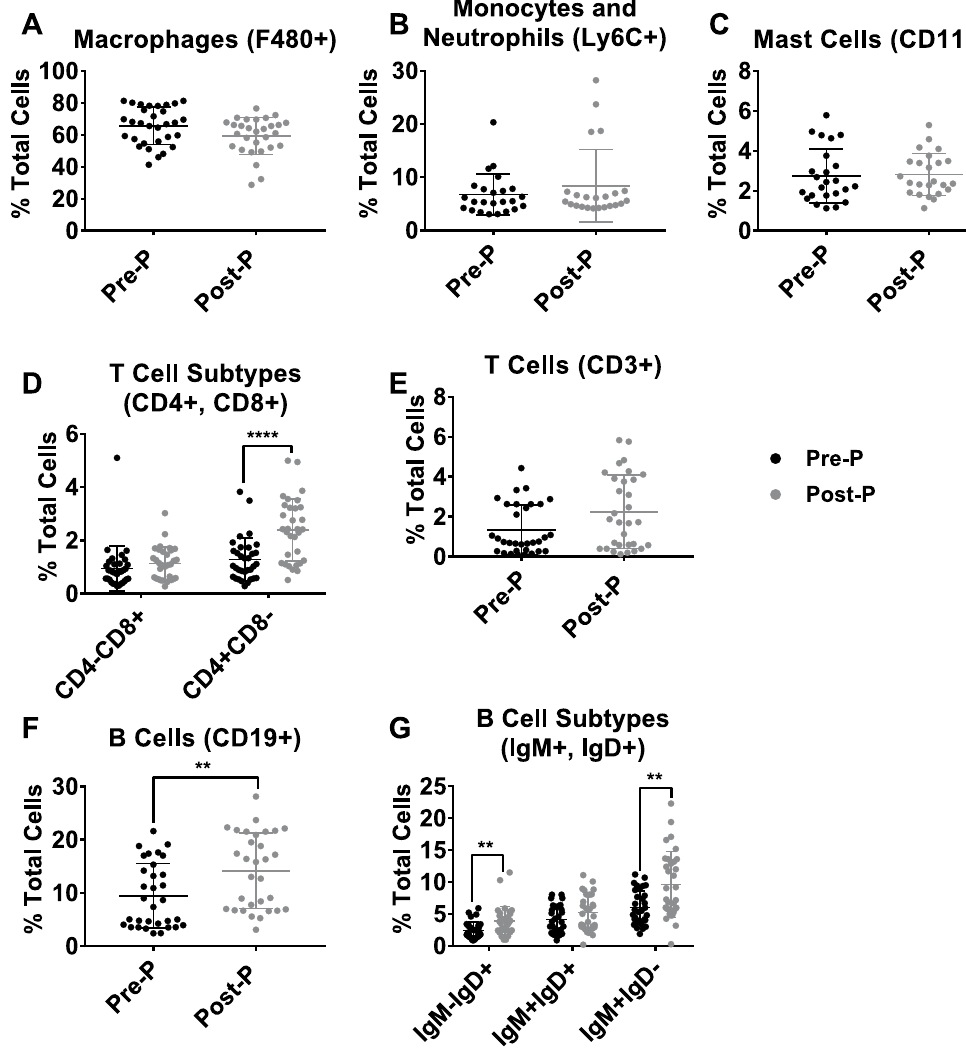
Figure 6. Pre- and post-pubertal (Pre-P, Post-P) mice show similar naïve peritoneal cell profiles. Naïve peritoneal cells from pre- and post-pubertal C57Bl/6 mice were collected through peritoneal lavage. Cells were blocked to prevent non-specific binding and then treated with antibodies for subsequent immuno-phenotypic analysis by flow cytometry. These included (A) F4/80 + Macrophages, (B) Ly6C + Monocytes and Neutrophils, (C) CD117 + Mast Cells, (D) CD3 + T cells and associated (E) CD4 + and CD8 + subsets and (F) CD19 + B cells and associated (G) IgM + and IgD + subsets. Black closed circles signify pre-pubertal data. N ≥ 23/group. For each sample, a total of ten thousand cells were analysed using the gating strategy described in Figure S8. Significant differences in concentration between pre- and post-pubertal mice are labelled with ** (p < 0.01). All comparisons were made using the Mann Whitney